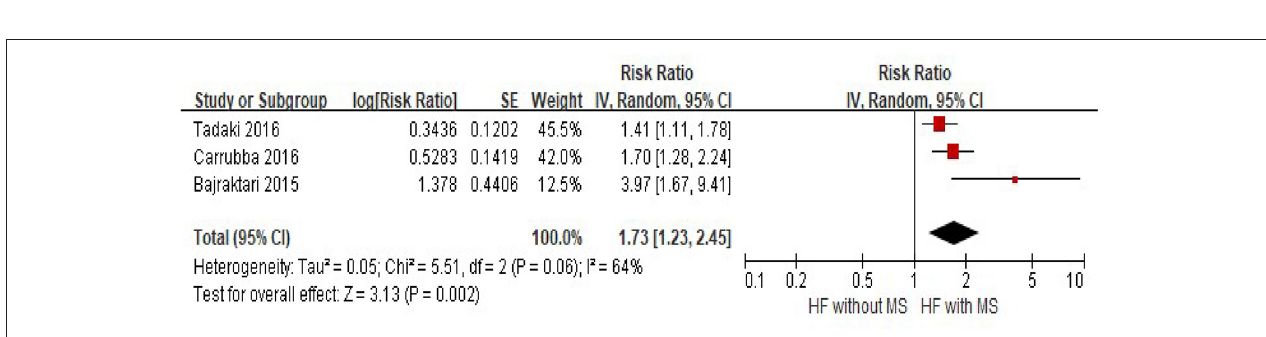
FIGURE 4 | The association of MS and the risk of composite cardiovascular events in HF patients. CVD, cardiovascular disease; CI, confidence interval; HF, heart failure; MS, Metabolic